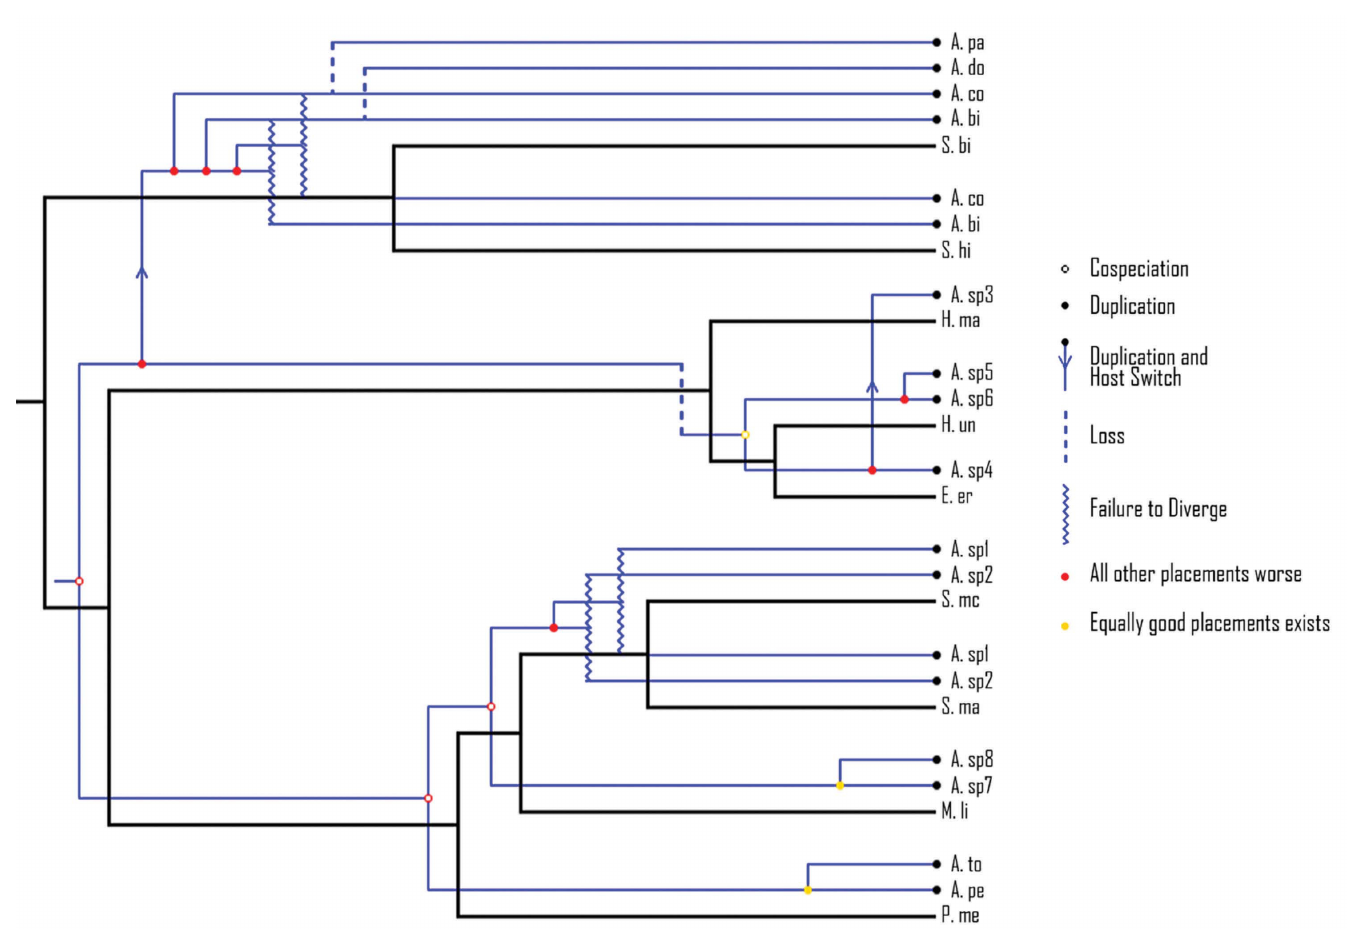
Fig 5. One of the 60 possible cophylogenetic reconstructions of Anacanthorus spp. and their hosts returned by Jane. Black branches (independent) represent the host phylogeny. Blue branches (dependent) correspond to the parasite phylogeny. The events and costs considered were cospeciation (0), duplication (1), duplication followed by host switching (2), loss (1) and failure to diverge (1). Abbreviations of species names are the same as in Fig